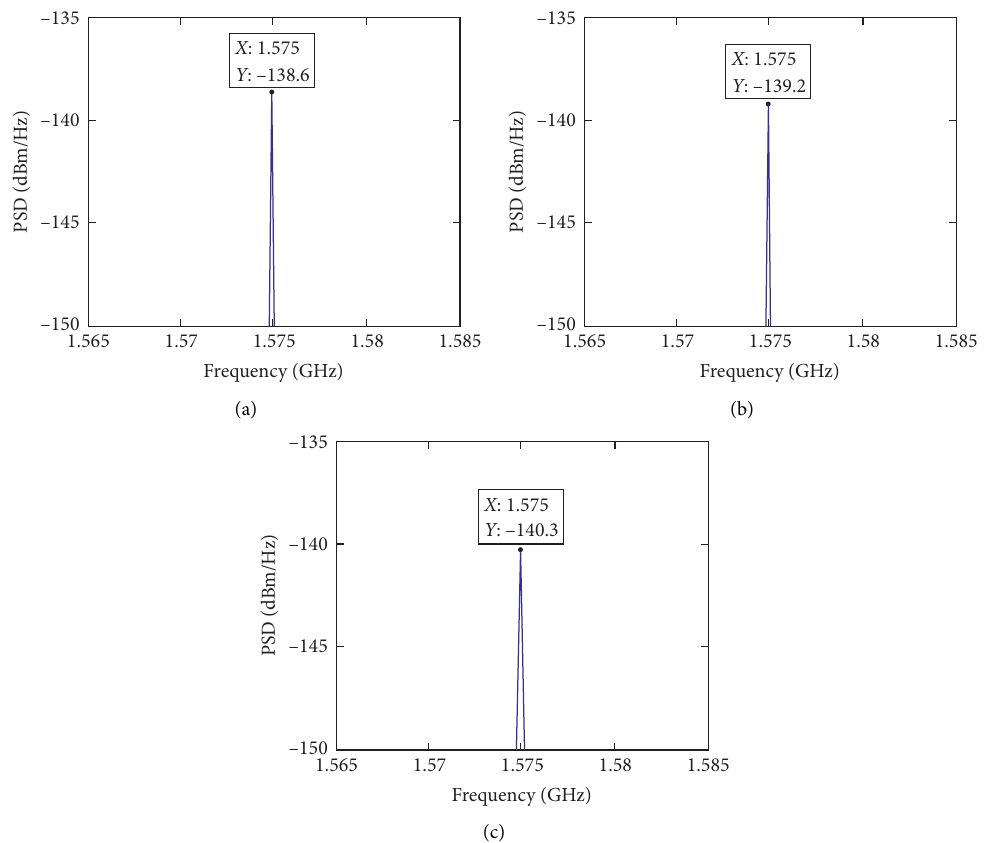
Figure 7: UWB signal power spectrum at PRF � 15.75 MHz. (a) Np � 10. (b) Np � 30. (c) Np � 50.